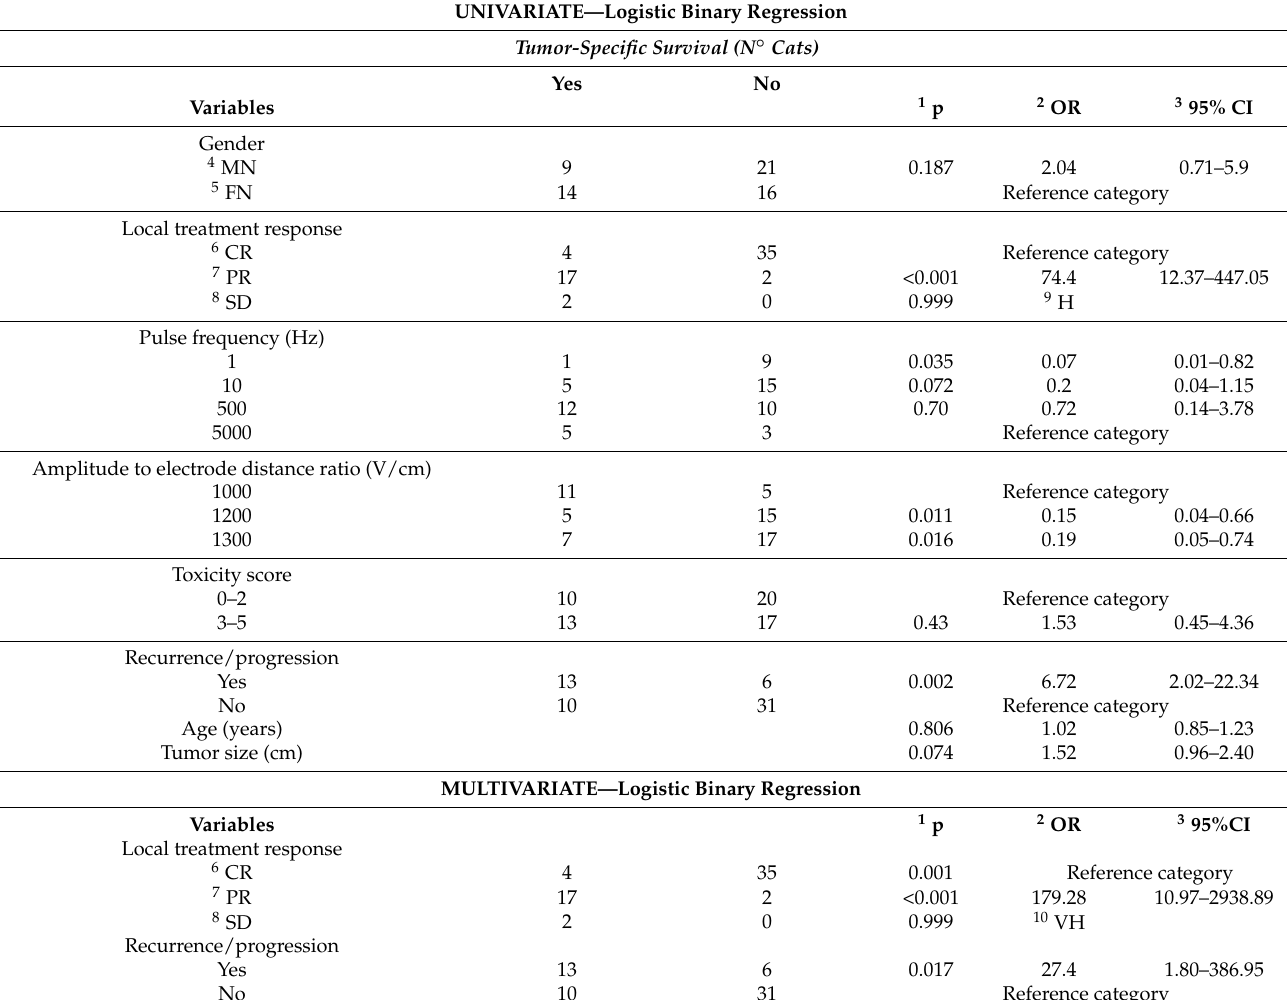
Table 3. Univariate and multivariate analyses for the relationship between variables and tumor-specific survival.